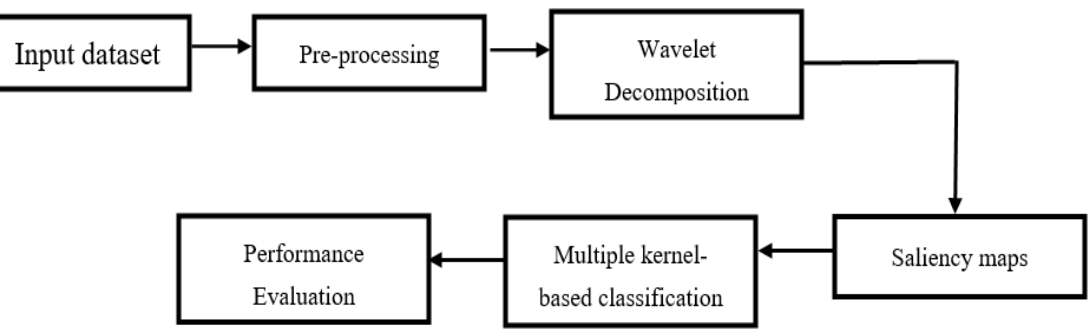
Figure 2. Block diagram of proposed visual saliency-based AD classification. Figure 2 shows an overall block diagram of the proposed visual saliency-based Alzheimer’s disease classification. The proposed system framework consists of two impor- tant sections—saliency map generation and AD